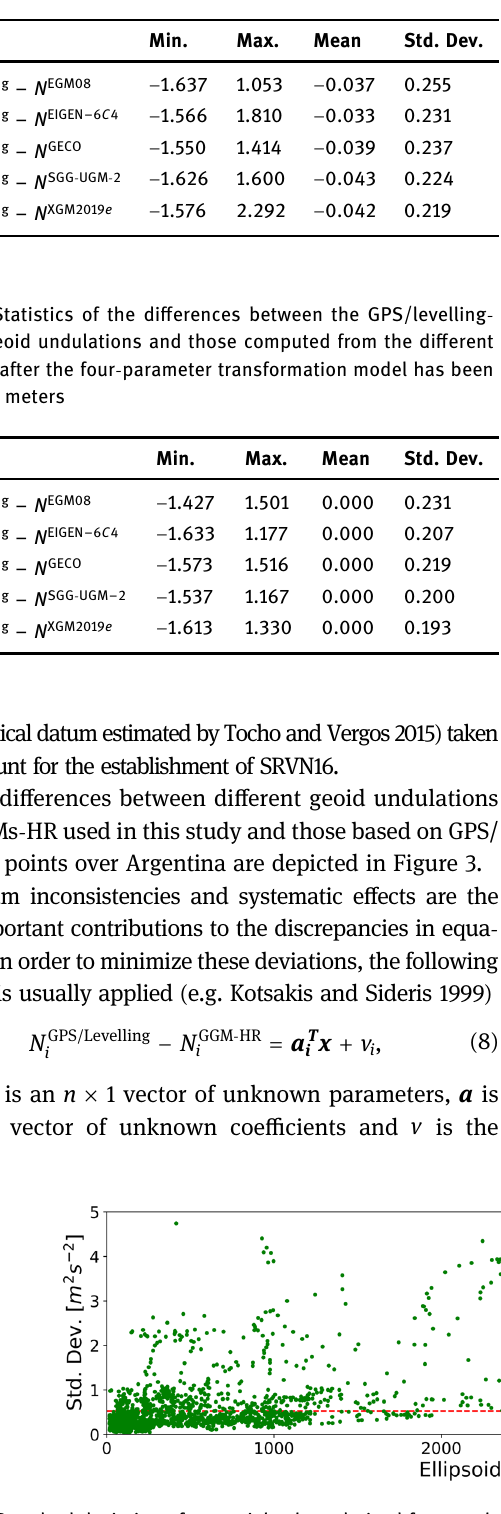
Figure 4: Standard deviation of potential values derived from each GGMs - HR as a function of the ellipsoidal height of each benchmark ( green dots ) . The red - dashed curve indicates the mean standard deviation from all benchmarks.